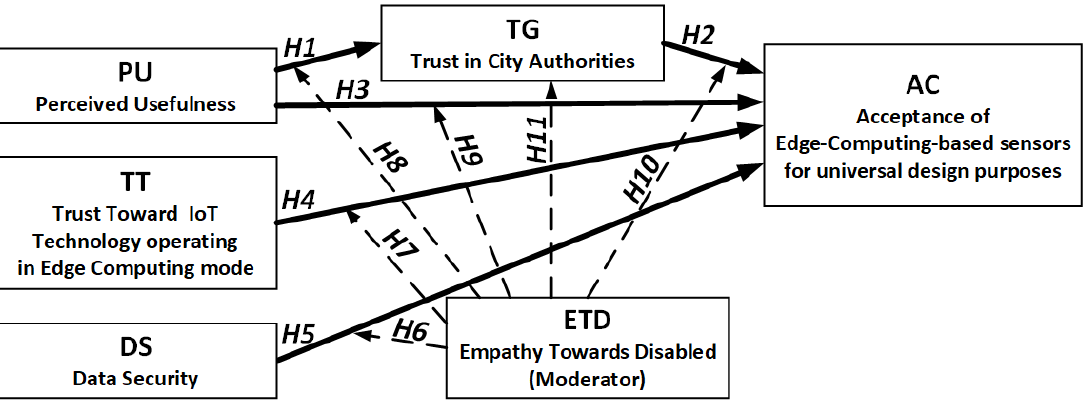
Figure 1. Structural model of the acceptance of IoT technology used in smart cities for universal design purposes.